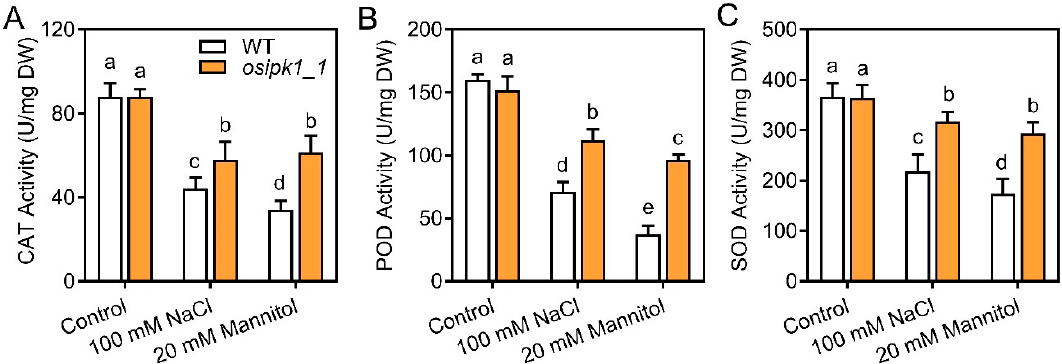
Figure 7. Activity of catalase (CAT) ( A ), peroxidase (POD) ( B ) and superoxide dismutase (SOD) ( C ) in Xidao #1 (WT) and its OsIPK1 mutant line osipk1_1 . All analyses were performed with three replicates. Error bars represent standard error. The different letters (a, b, c, d, and e) show the significant difference at a probability of p ˂ 0.05.